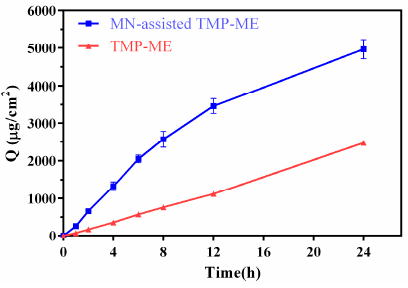
Figure 3. Cumulative in vitro skin permeation for TMP-ME and MN-assisted TMP-ME.